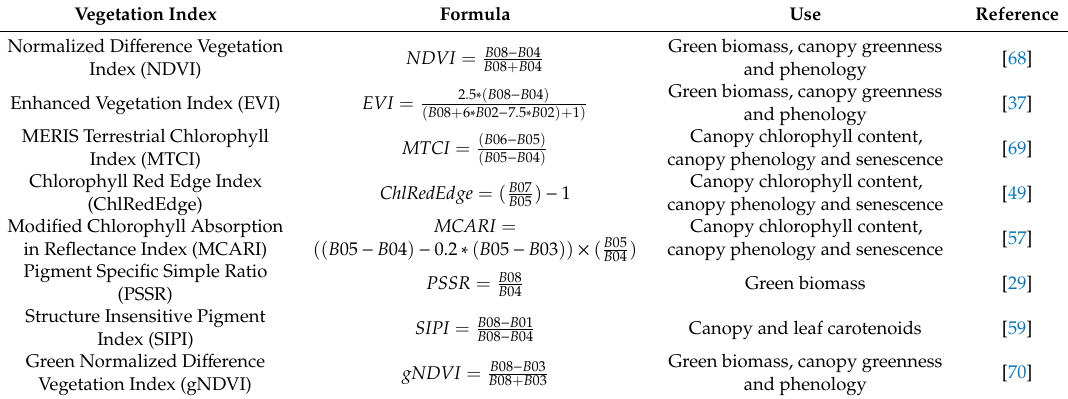
Table 1. Vegetation indices (VIs) derived from Sentinel-2. Abbreviations correspond with center wavelengths, in nm: B02 = reflectance at 490 nm; B03 = reflectance at 560 nm; B04 = reflectance at 665 nm; B05 = reflectance at 705 nm; B06 = reflectance at 740 nm; B08 = reflectance at 842 nm. B02, B04 and B08 have a 10 m spatial resolution, while B05 and B06 have a 20 m